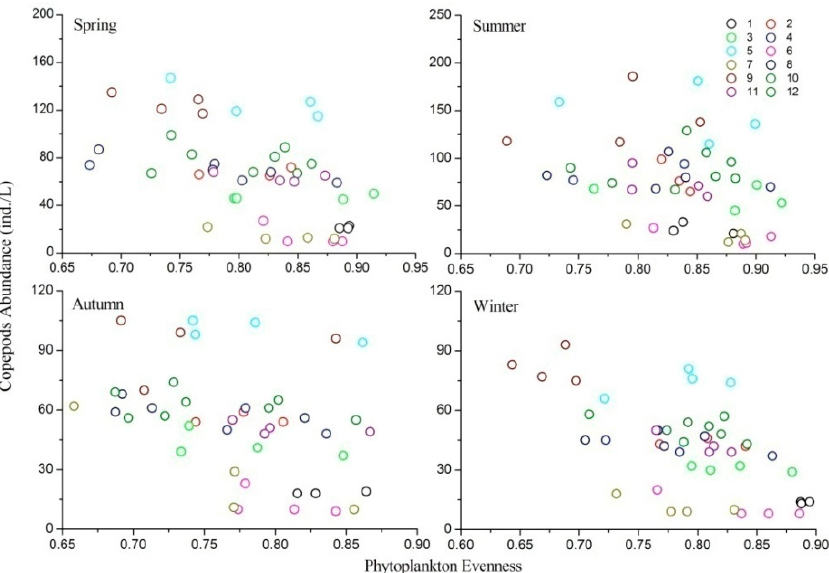
Figure 5. Relationships between phytoplankton evenness and copepod abundance in different seasons.